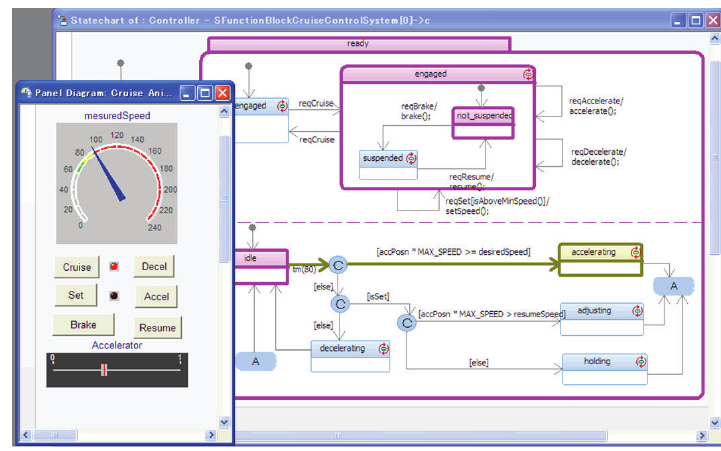
Figure 27: Animation of a state machine diagram of Controller block and a panel